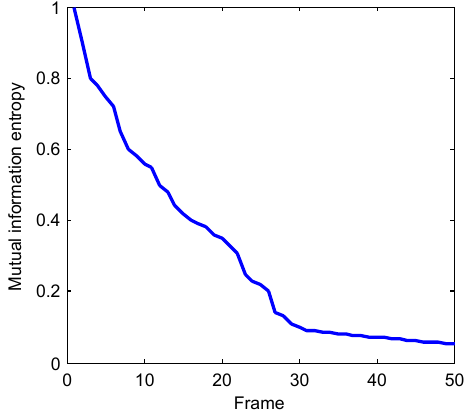
Figure 4. Mutual information entropy between the current frame and other